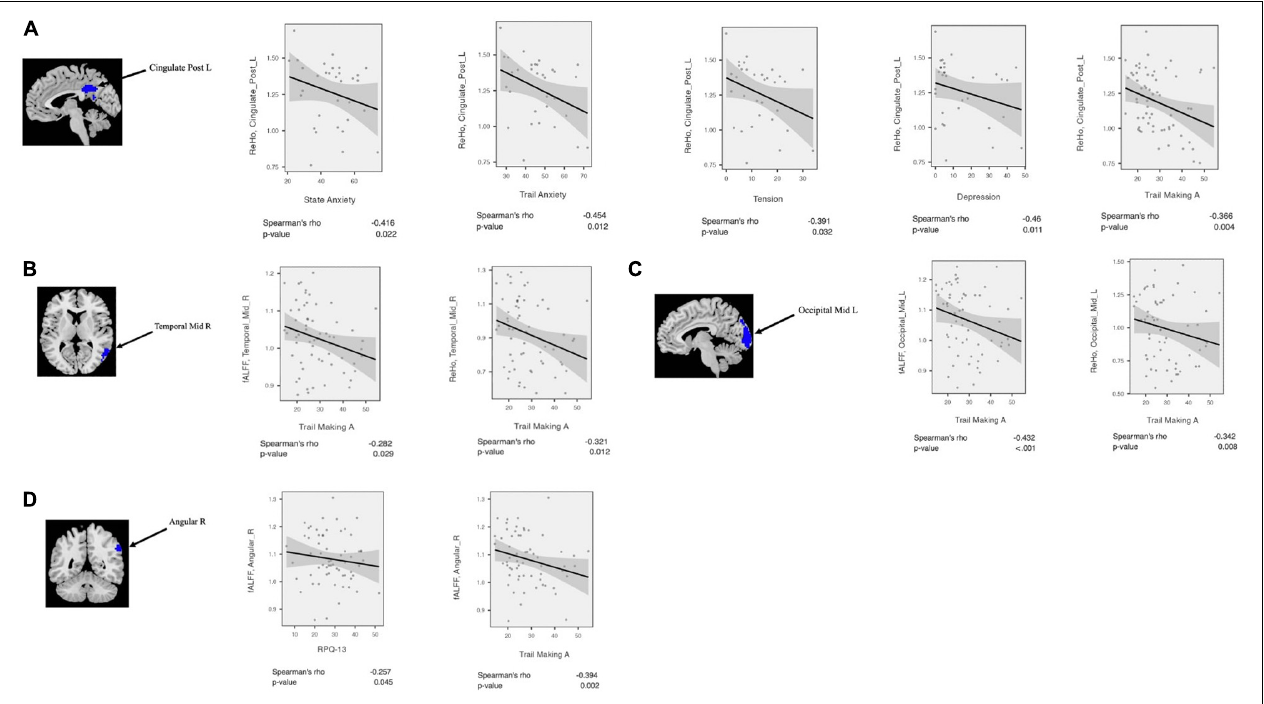
FIGURE 4 | Correlation analysis between fALFF/ReHo and neuropsychological scores among mTBI patients in the clusters with significant fALFF/ReHo differences between mTBI patients and controls including (A) Cingulate_Post_L, (B) Temporal_Mid_R, (C) Occipital_Mid_L, and (D)